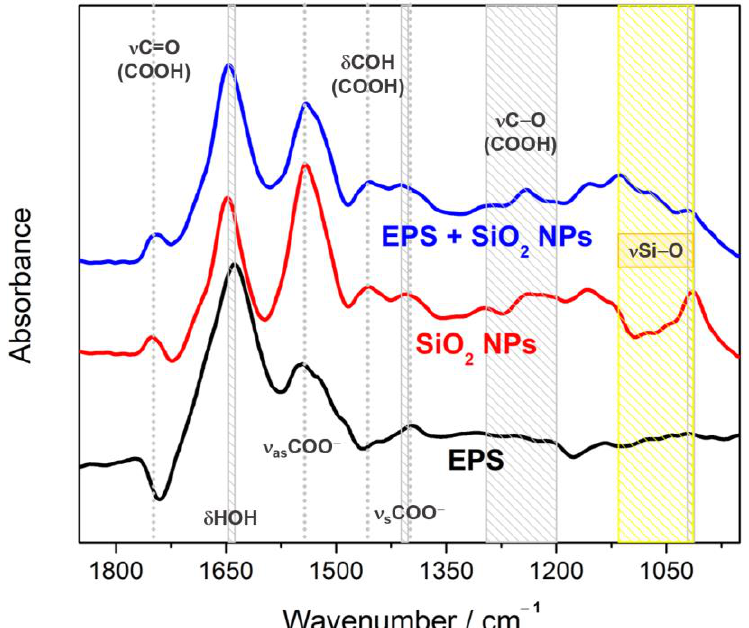
Figure 4. Normalized and stacked FTIR spectra (1850–950 cm − 1 ) of EPS (black curve), SiO 2 NPs (red curve), and their mixture EPS + SiO 2 NPs (blue curve) prepared in SW obtained after SW spectra subtraction. The positions of the discussed bands are designated with dotted gray lines (if their maximum position is maintained across different systems) or as rectangles that emphasize their displacement (gray) or qualitatively different spectral envelope